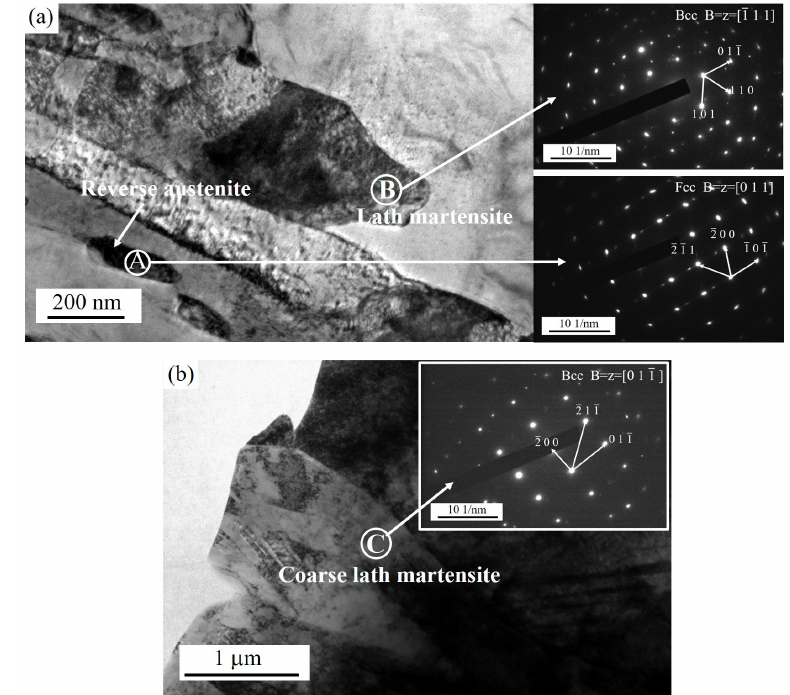
Figure 6. TEM base material and martensite in the coarse-grained region reverse transformed Table 3. Average of the maximum penetration depth and the ration to base metal.